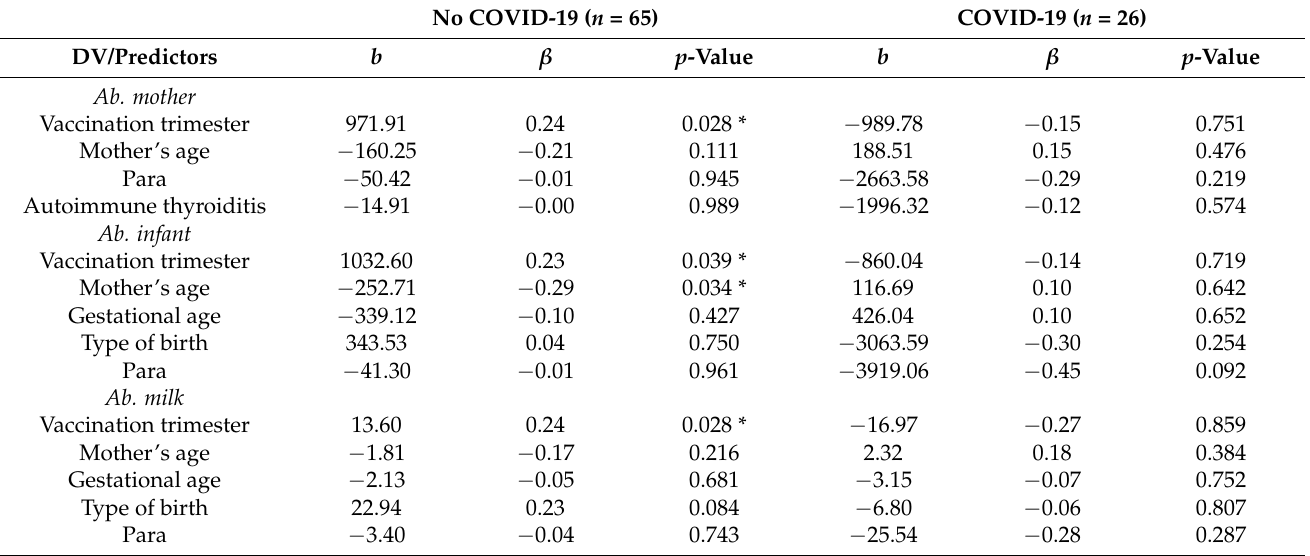
Table 2. Regression analysis.